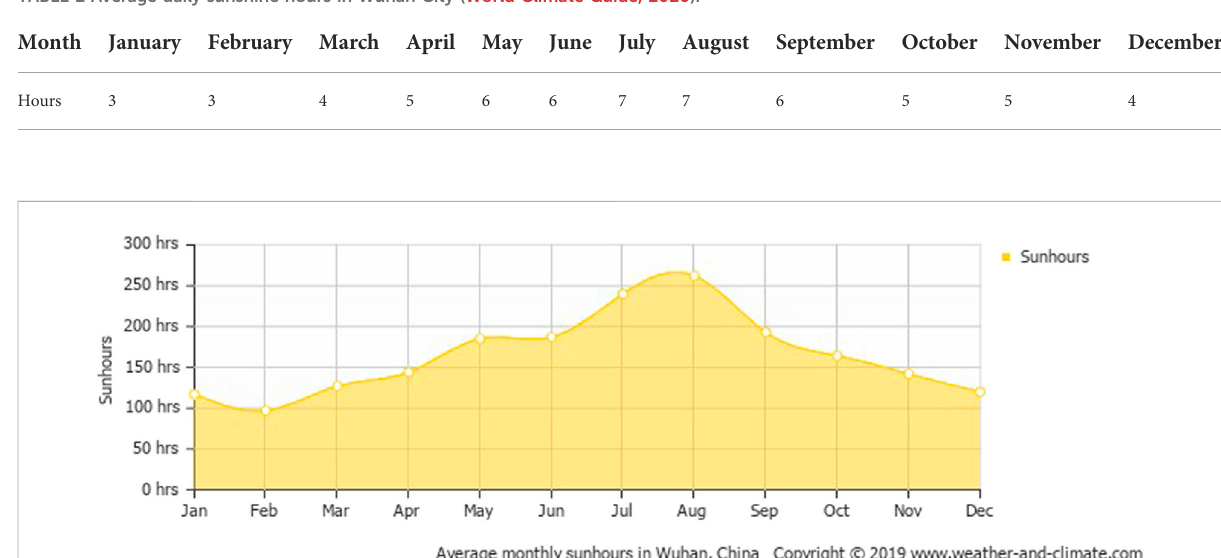
FIGURE 2 Average monthly hours of sunshine in Wuhan (Hubei) (W&C and Climate, 2020).